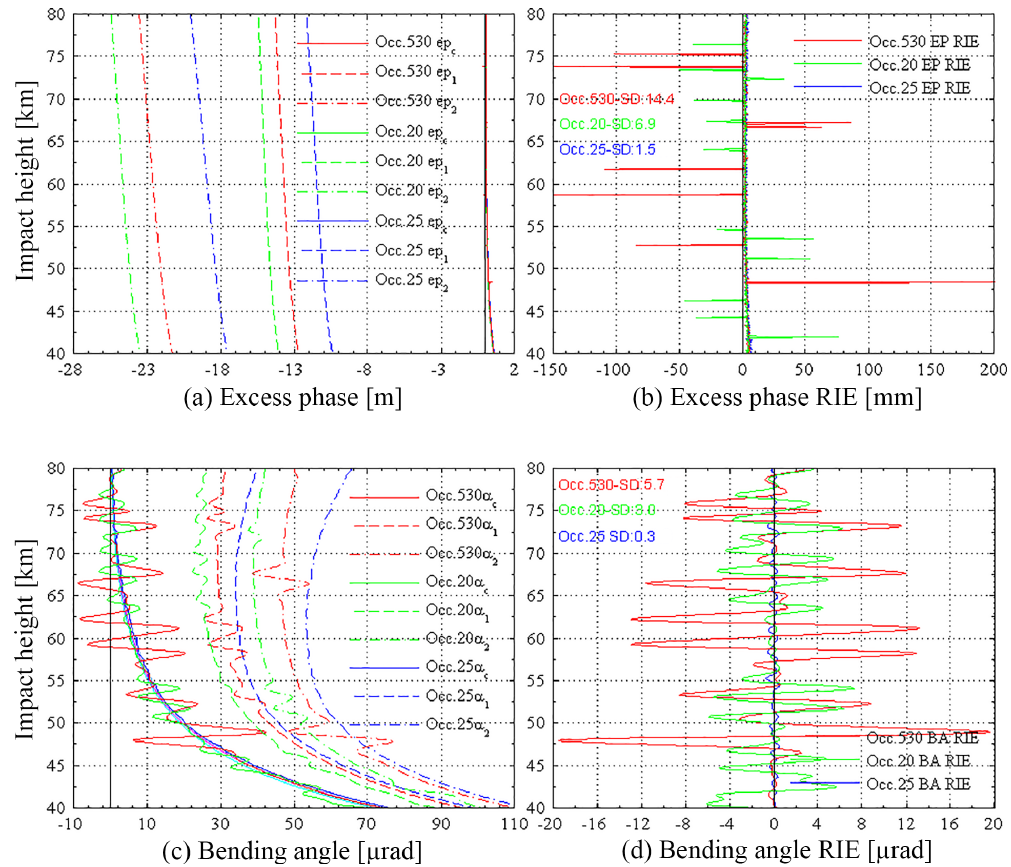
Figure 3. Illustration of the three example events chosen for detailed inspection (Occ.530, red; Occ.20, green; Occ.25, blue), showing their excess-phase profiles (a) , excess-phase RIE profiles (b) , bending angle profiles (c) , and bending angle RIE profiles (d) over the impact height range 40 to 80km for medium solar activity (F10.7 = 140) and non-spherical-symmetry (ns) ionosphere conditions. The excess-phase and bending angle profiles are shown for both GPS frequencies L1 (dashed) and L2 (dashed-dotted) as well as after standard first-order ionospheric correction (subscript c; solid). Table 1. Parameters of the three representative RO events used for detailed inspection. Azimuth of the RO event plane is defined relative to north, counting over